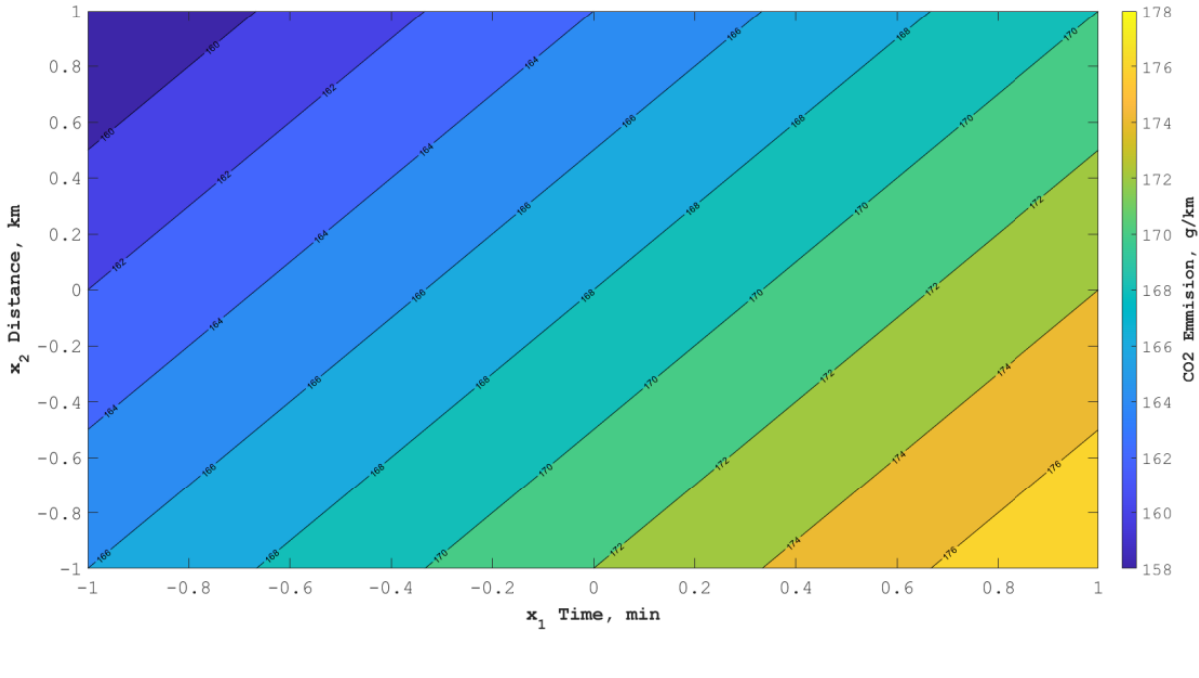
Figure 9. Change in CO 2 emission depending on the variability of factors x 1 and x 2 for a vehicle (ICE) moving at a temperature of 20 °C (x 3 = 0).